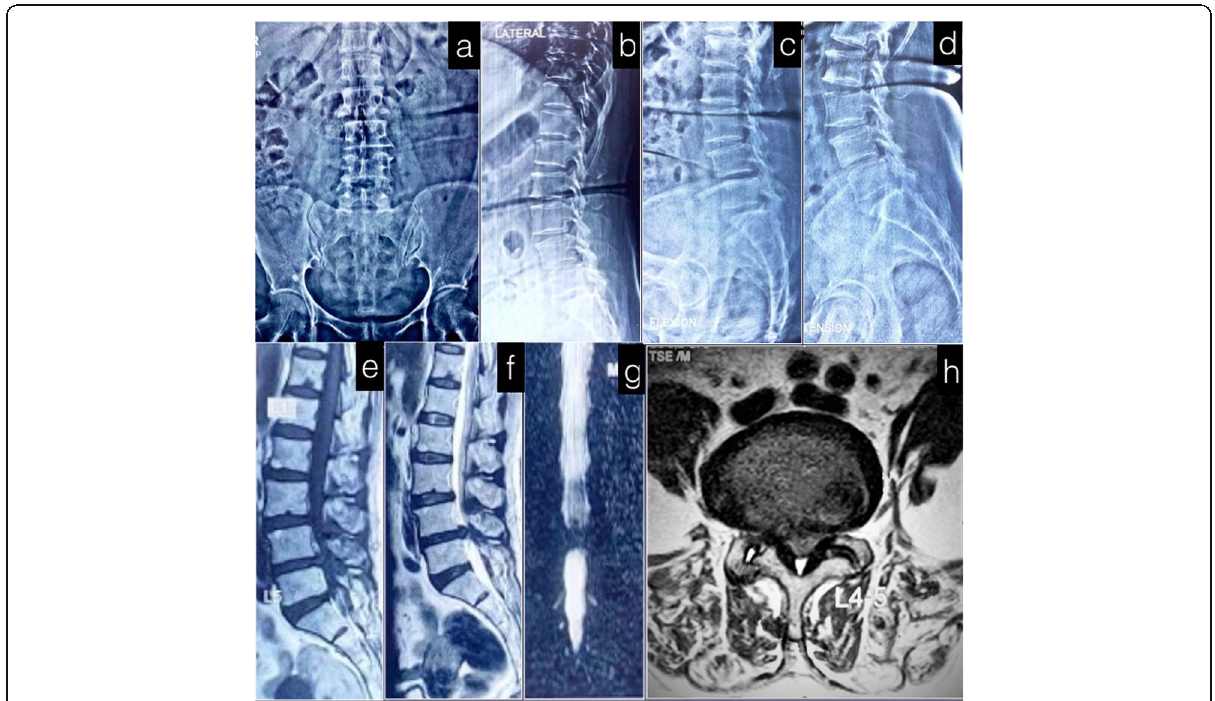
Fig. 1 a – d Antero-posterior, neutral standing lateral, flexion, and extension radiograph of the patients showing grade 1 listhesis at L4 – 5 level. e , f T1 and T2 sagittal MRI sections showing a disc prolapse with buckled annulus and reduced disc space. g The MR myelogram showing complete myeloblock. h T2 axial film showing ligamentum flavum (dorsal stenosis) with facet tropism, a buckled annulus, and disc protrusion